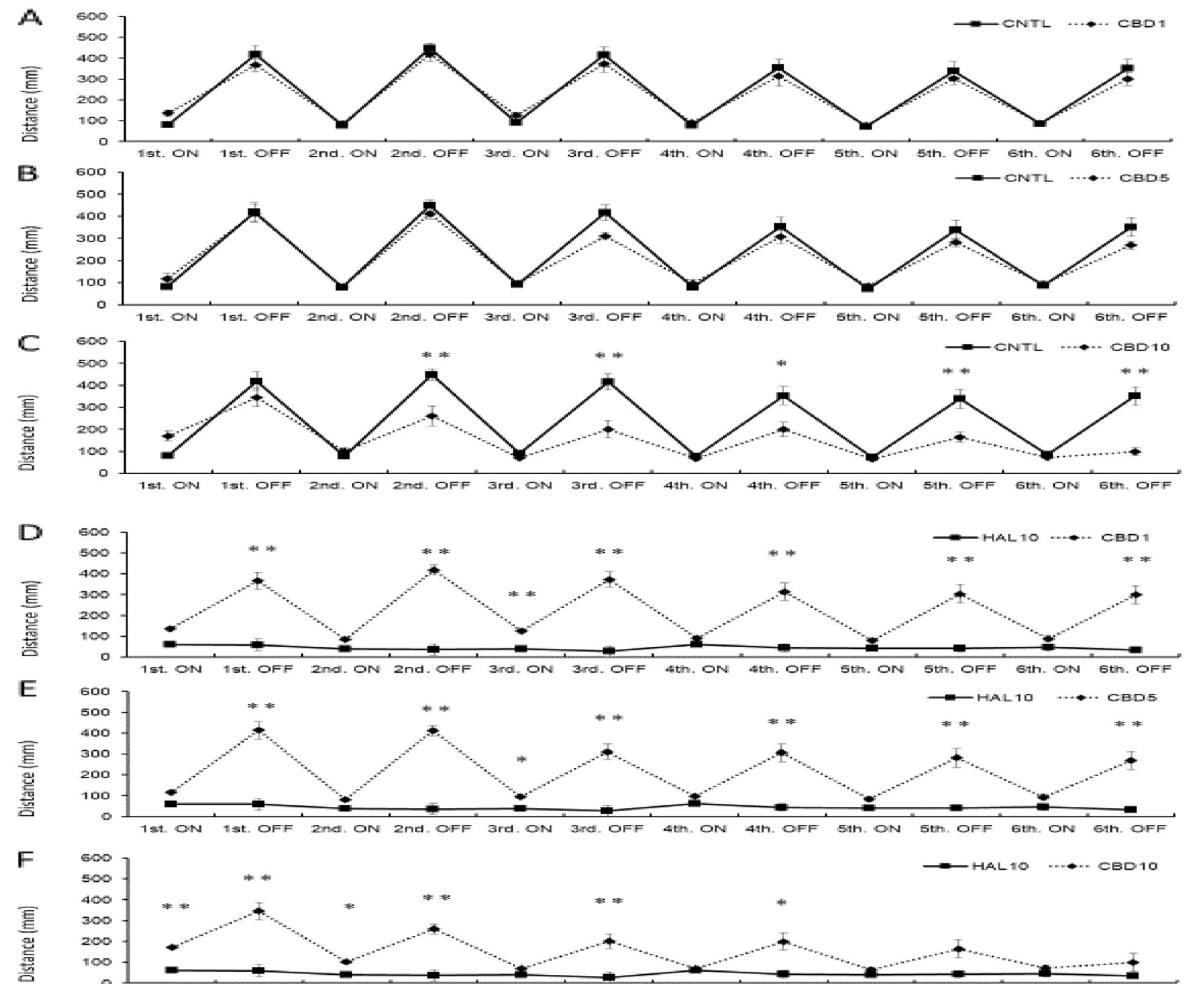
Fig. 6. Effect of CBD on light/dark-stimulation response. There were no significant differences from CNTL and CBD 1 mg/L nor 5 mg/L ( a , b ). The distance traveled in the second, third, fourth, fifth, and sixth dark condition decreased in the CBD 10 mg/L group compared with the CNTL ( c ). In the CBD1 and CBD5 groups, the distance traveled in all dark conditions showed a significant difference compared with HAL 10 mg/L ( d , e ). In the CBD 10 mg/L group, although the distance traveled in the first and second light and dark conditions, the third and fourth dark conditions showed a significant difference compared with HAL 10 mg/L ( f ). CNTL: Control, HAL10: Haloperidol 10 mg/L, CBD 1, 5, 10: Cannabidiol 1, 5, 10 mg/L, ON: light-on period, OFF: light-off period. Tukey–Kramer test; * p <0.05, ** p <0.01. All values are presented as means